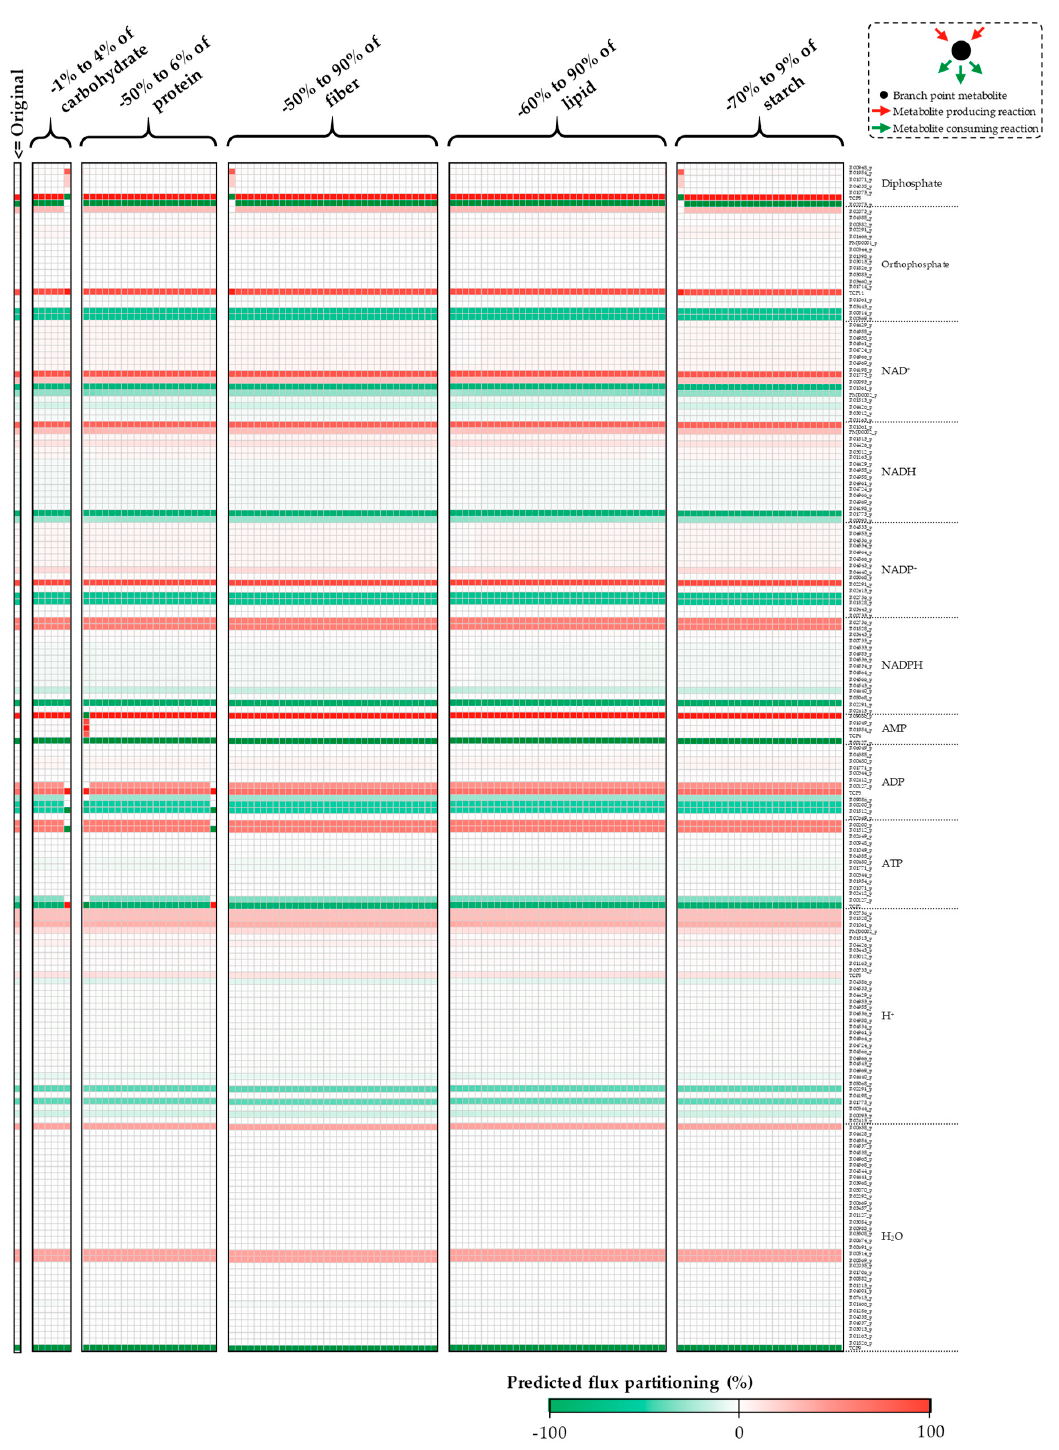
Figure A15. The sensitivity of plastidial reaction flux partitioning to variations in biomass content. Details of the metabolic branch points along with the corresponding reactions are provided in the Supplementary Materials (File S2). A difference in grid color between the original (first column) and predicted fluxes is indicative of dissimilarity in partitioning (breakpoint). The production and consumption fluxes at each metabolic branch point were respectively denoted as positive and negative signs. 2-( α -Hydroxyethyl)ThPP, 2-(alpha-hydroxyethyl)thiamine-diphosphate.